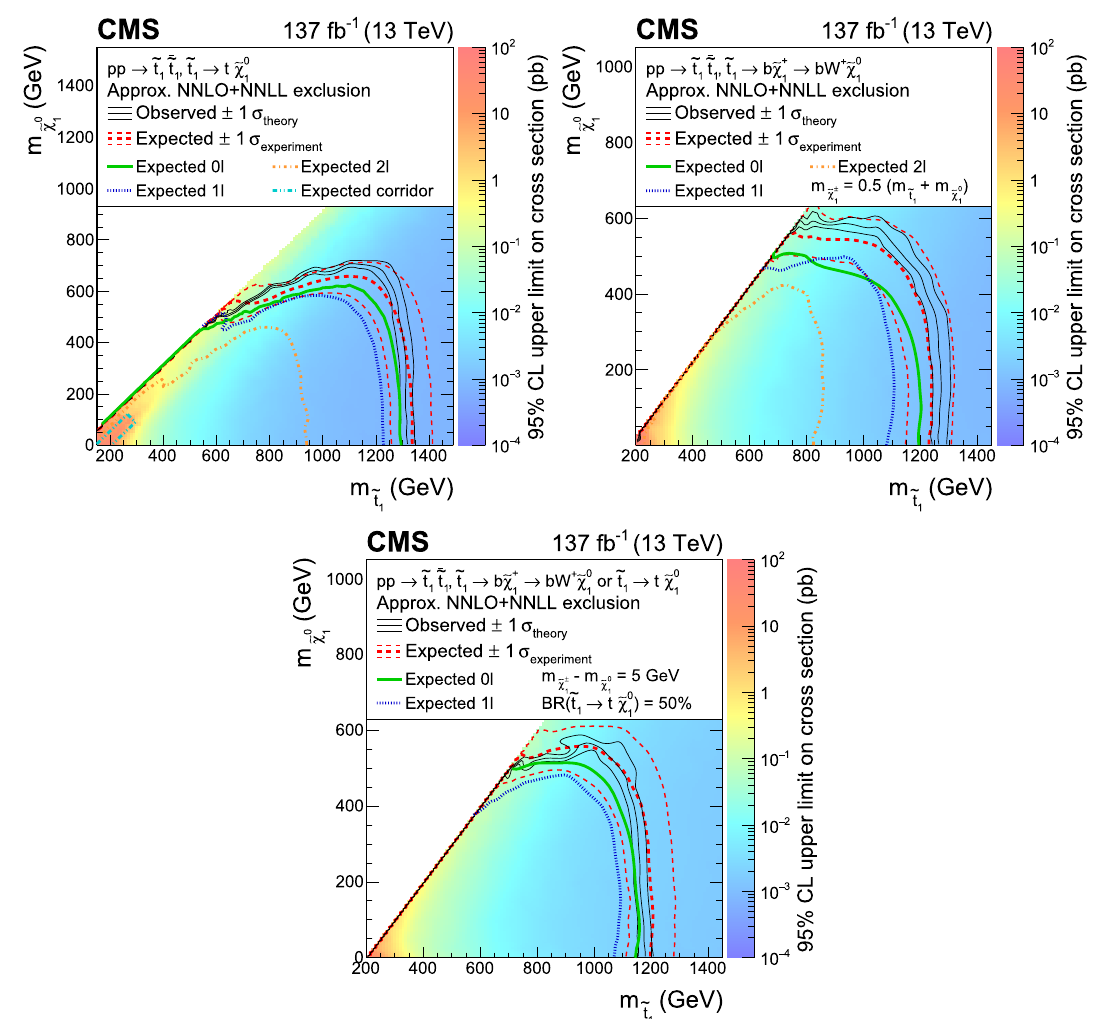
Fig. 9 Expectedandobservedlimitsinthe m (cid:2) t1 - m below the thick black curve represents the observed exclusion region at massplane,forthe (cid:2) χ 0 1 95% CL, while the dashed red lines indicate the expected limits at 95% (cid:2) t (cid:2) t → t (cid:2) χ 0 → b (cid:2) χ + → bW + (cid:2) χ 0 CL and the region containing 68% of the distribution of limits expected 1 1 1 model (upper left), the 1 model (upper 1 right) and a model with a branching fraction of 50% for each of these under the background-only hypothesis of the combined analyses. The top squark decay modes (lower), assuming a mass difference between thin black lines show the effect of the theoretical uncertainties in the the neutralino and chargino of 5GeV. The color indicates the 95% CL signal cross upper limit on the cross section at each point in the plane. The area